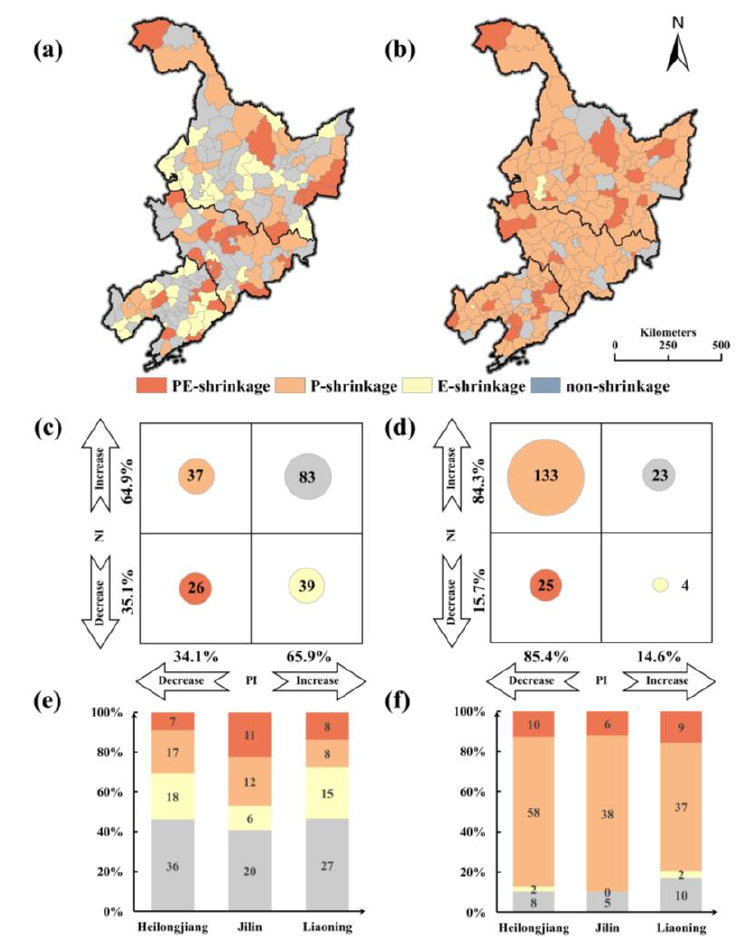
Figure 8. ( a ) The spatial distribution of different shrinkage types in S1 (1996 – 2009); ( b ) the spatial distribution of different shrinkage types in S2 (2010 – 2020); ( c ) the number of different shrinkage types in S1 (1996 – 2009); ( d ) the number of different shrinkage types in S2 (2010 – 2020); ( e ) the proportion of different shrinkage types by province in S1 (1996 – 2009); and ( f ) the proportion of different shrinkage types by province in S2 (2010 – 2020).